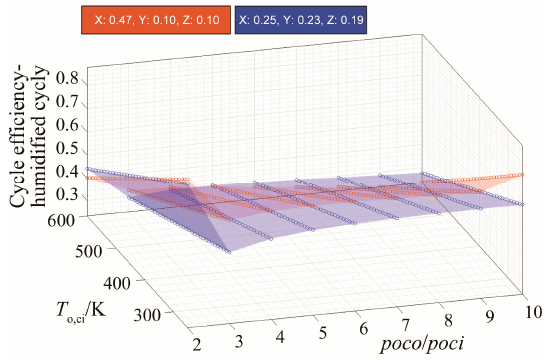
Figure 9. Efficiency results for blend 58 and the new blend. Figure 9. E ffi ciency results for blend 58 and the new